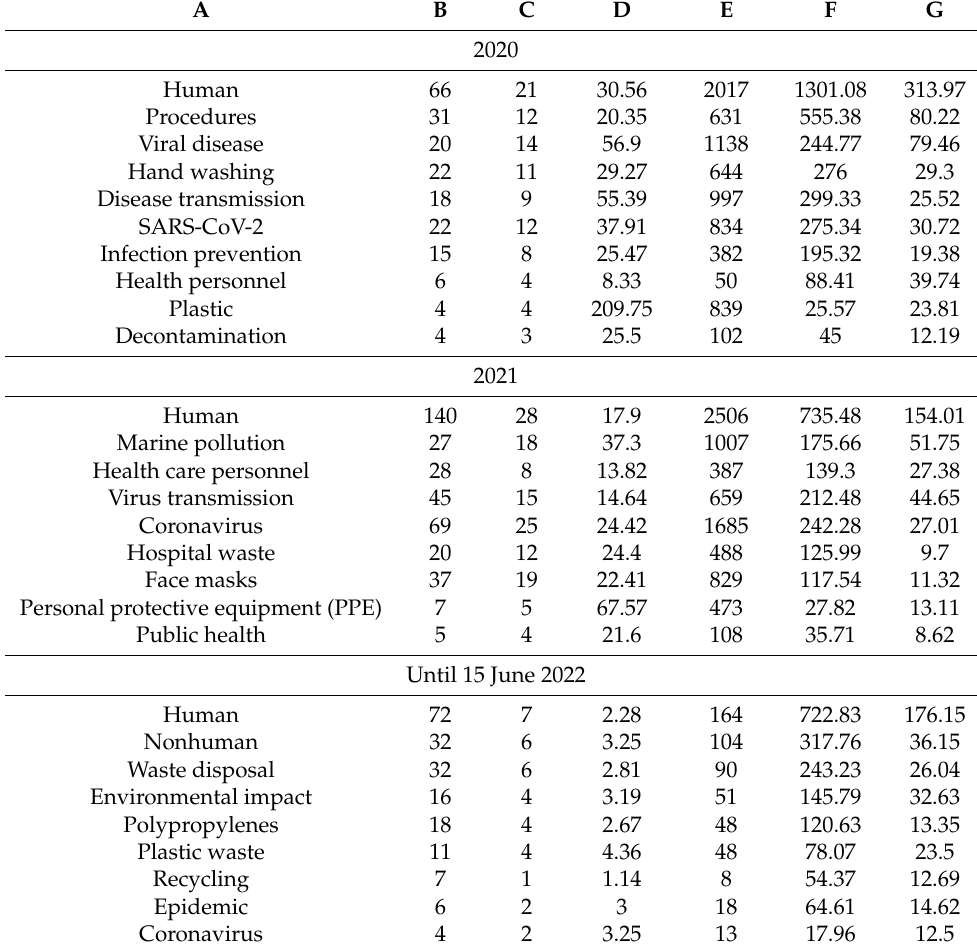
Table 6. Performance measures for themes for subperiods of the time